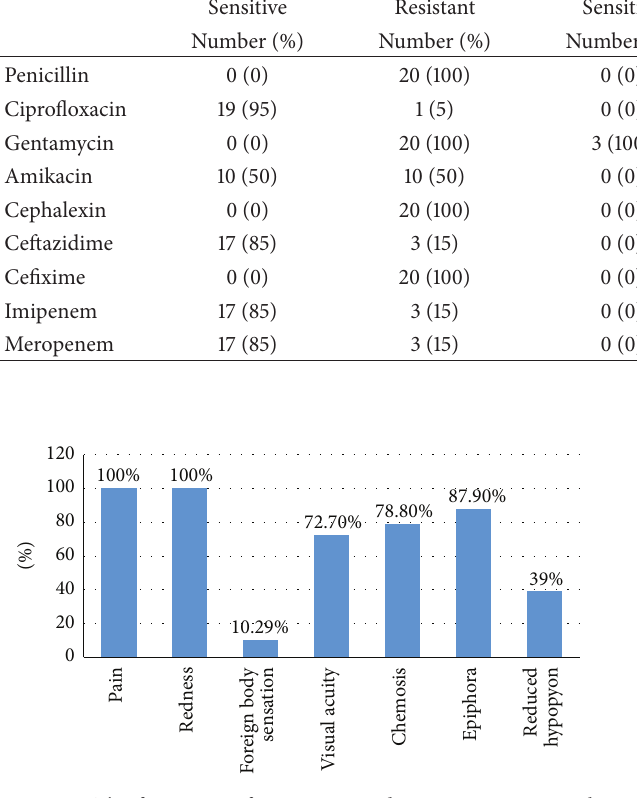
Figure 1: The frequency of symptoms and signs in patients with microbial keratitis.